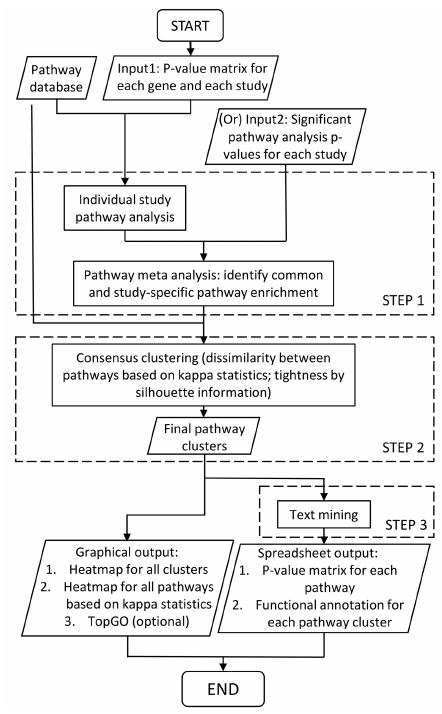
Figure 1. Workflow of Comparative Pathway Integrator